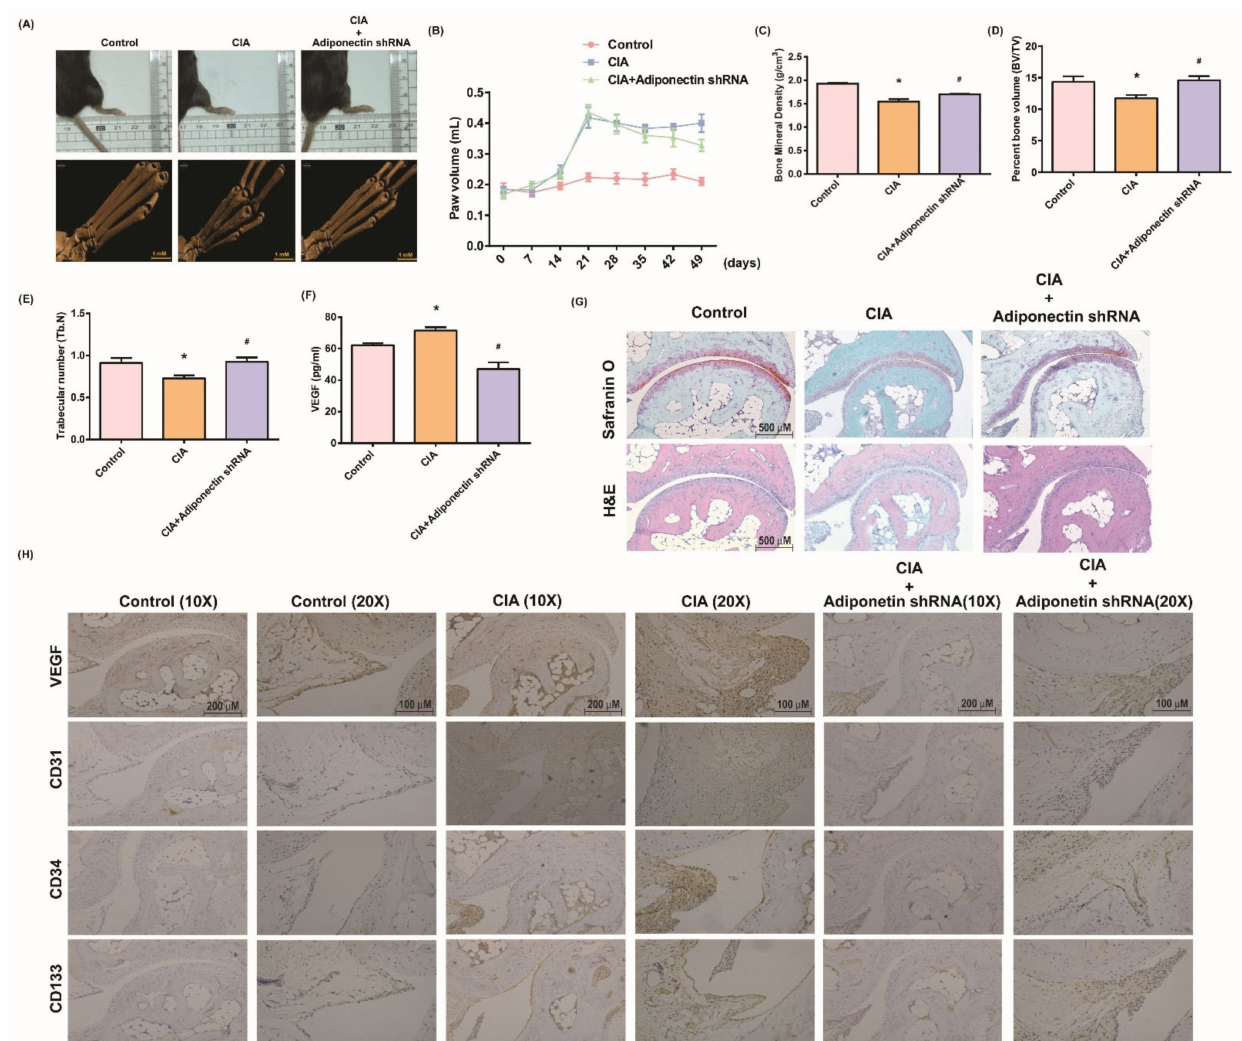
Figure 7. Lentivirus carrying adiponectin short hairpin RNA (sh-adiponectin) reduces bone erosion and angiogenic expression in a CIA model. ( A , B ) CIA mice received intra-articular injections of 7.1 × 10 6 PFU adiponectin shRNA on day 14 and were euthanized on day 49. Hind paw swelling was photographed and measured with a digital plethysmometer in the different groups (Control, CIA, and CIA mice receiving intra-articular lentiviral sh-adiponectin; n = 8 per group). Representative micro-CT images of the hind paws were recorded on Day 56. ( C – F ) Micro-CT SkyScan Software quantified bone mineral density (BMD), bone volume percentage (BV/TV), and trabecular numbers (Tb. N.). VEGF serum levels were determined by ELISA. ( G , H ) Histological sections of ankle joints were stained with H&E or Safranin O and immunostained with CD31, CD34, and CD133. * p < 0.05 versus the control group; # p < 0.05 versus the untreated CIA